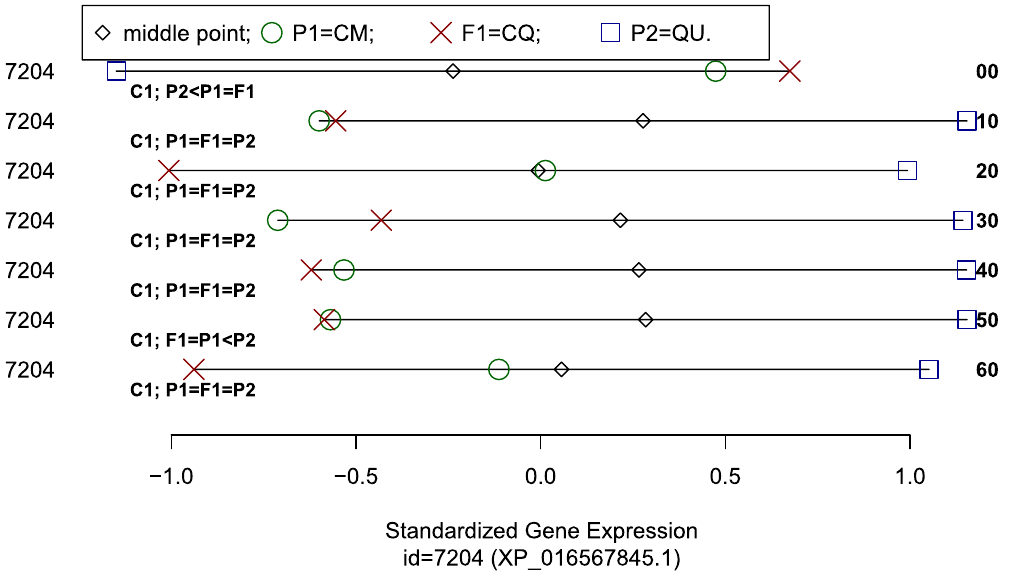
Figure 5. Standardized gene expression ( X -axis) for gene coding protein XP_016567845.1 at each time of development (rows in Y -axis). Left margin presents gene id while right margin gives the time of development in DAA. Each row is annotated with the cross ( C 1 ), followed by the